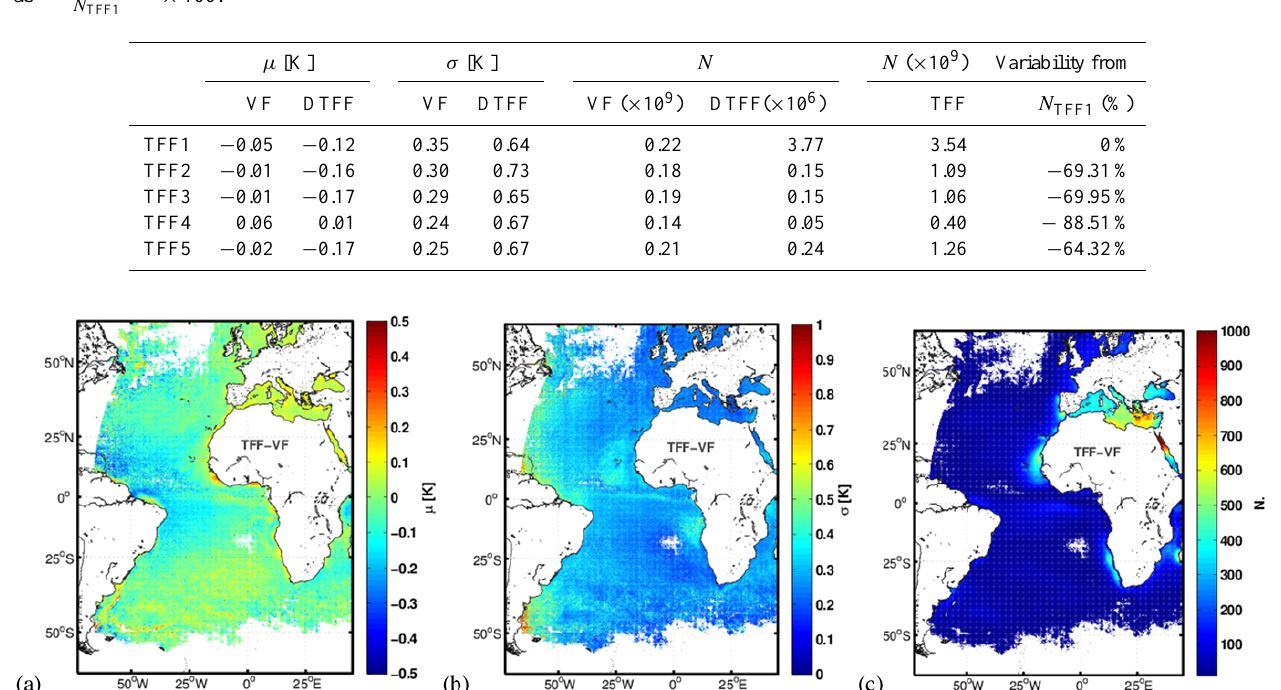
Table 3. Averaged statistics of TFF–VF and TFF–DTFF, for the period 2006–2011. The variability from the N of TFF1 is defined × 100. as N TFFX − N TFF1 N TFF1